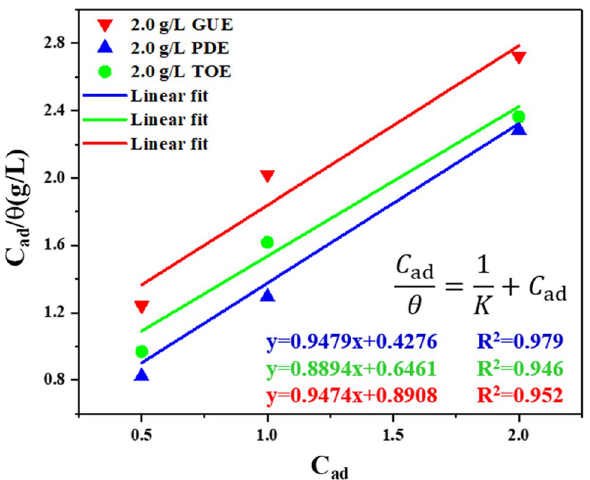
Figure 4. Langmuir adsorption isotherm for adsorption of GUE, PDE and TOE on AZ91